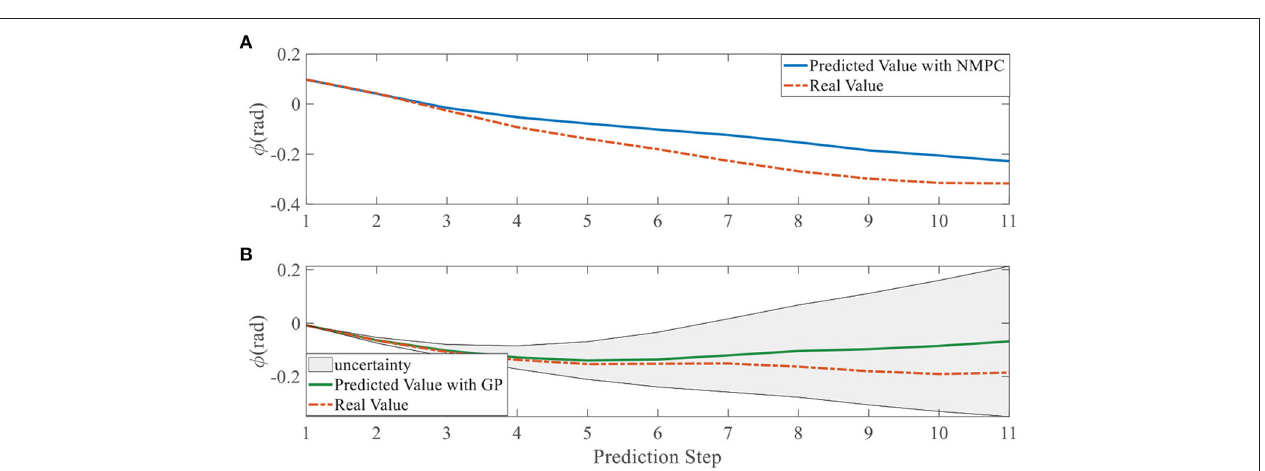
FIGURE 15 | Yaw angle evolution in right overtaking. (A) NMPC; (B) GPMPC.